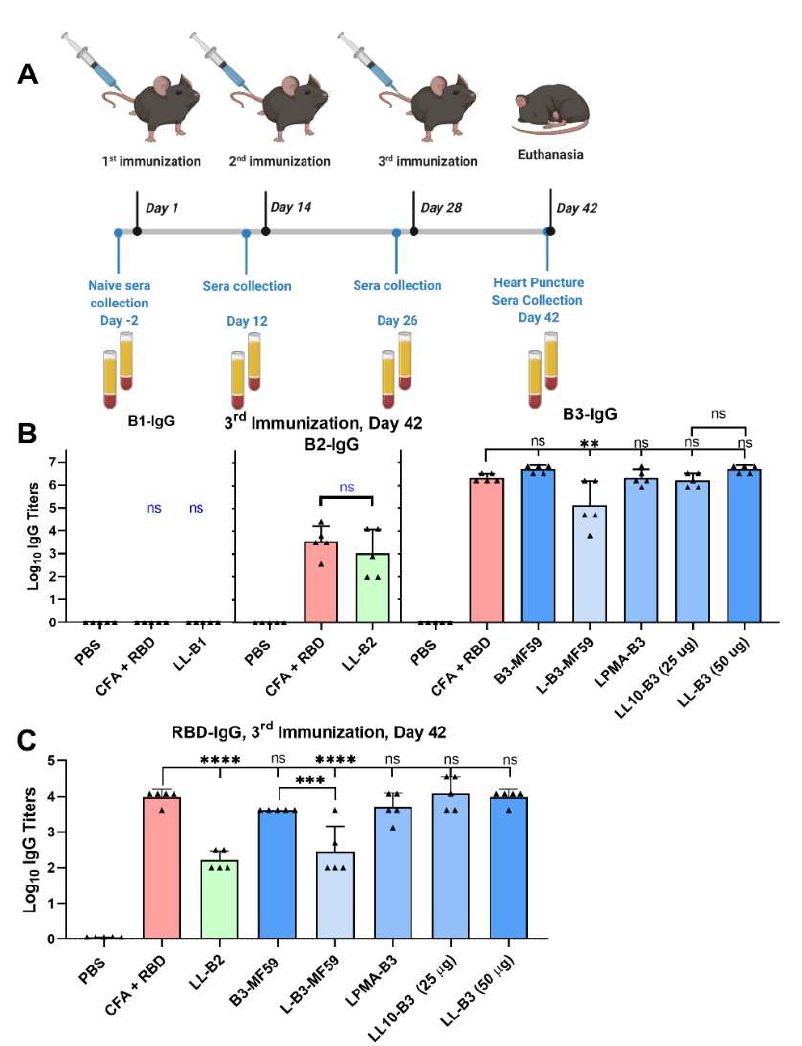
Figure 4. Adjuvant screening study in C57BL/6 mice. ( A ) Mice immunization schedule. ( B ) Antigen- specific serum IgG titers in mice immunized with liposomal formulation of conjugated antigens (LL-B1, LL-B2, LL-B3, LPMA-B3) and emulsion-based formulations (B3-MF59 and L-B3-MF59). An- tibody titers have been measured by ELISA with the plates coated with B1-B3 antigens to measure levels of B1-IgG, B2-IgG, and B3-IgG, respectively. ( C ) Anti-RBD IgG titers in the serum after three immunizations. Triangles describe individual mouse values in each group. Statistical analysis was performed using one-way ANOVA with Dunnett’s multiple comparison test. (ns) nonsignificant, p > 0.05; (**) p < 0.01; (***) p < 0.001, and (****) p < 0.0001. Generally, liposome/L 10 and MF59 (with soluble antigens) induced IgG titers as high as CFA-adjuvanted RBD after the first immunization. The antibodies produced had high avidity, recognizing RBD coated on ELISA plates. However, the addition of L 10 -conju- gated peptide antigen to MF59 reduced immunogenicity significantly, likely due to the peptides self-assembling separately from the emulsion oil globules (Figure S3).